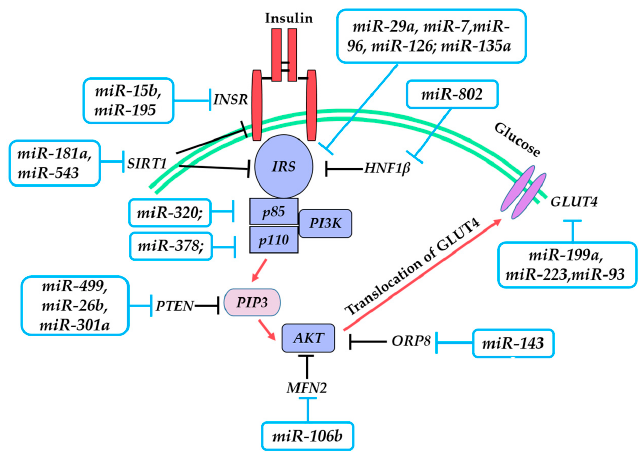
Figure 1. Major protein cascade and miRNAs in insulin signaling pathway. Red arrow—activation; T arrow—direct inhibition (blue); indirect inhibition (black). Abbreviations: INSR—insulin receptor ; IRS—insulin receptor substrate ; PI3K — phosphoinositide 3-kinase ; SIRT1 — sirtuin 1 ; PTEN — phosphatase and tensin homolog ; PIP3 — phosphatidylinositol 3,4,5-triphosphate ; MFN2 — mitofusin 2 ; AKT — AKT serine/threonine kinase ; ORP8 — oxysterol binding protein like 8 ; HNF1 β — hepatocyte nuclear factor 1- β ; GLUT4 — glucose transporter 4.